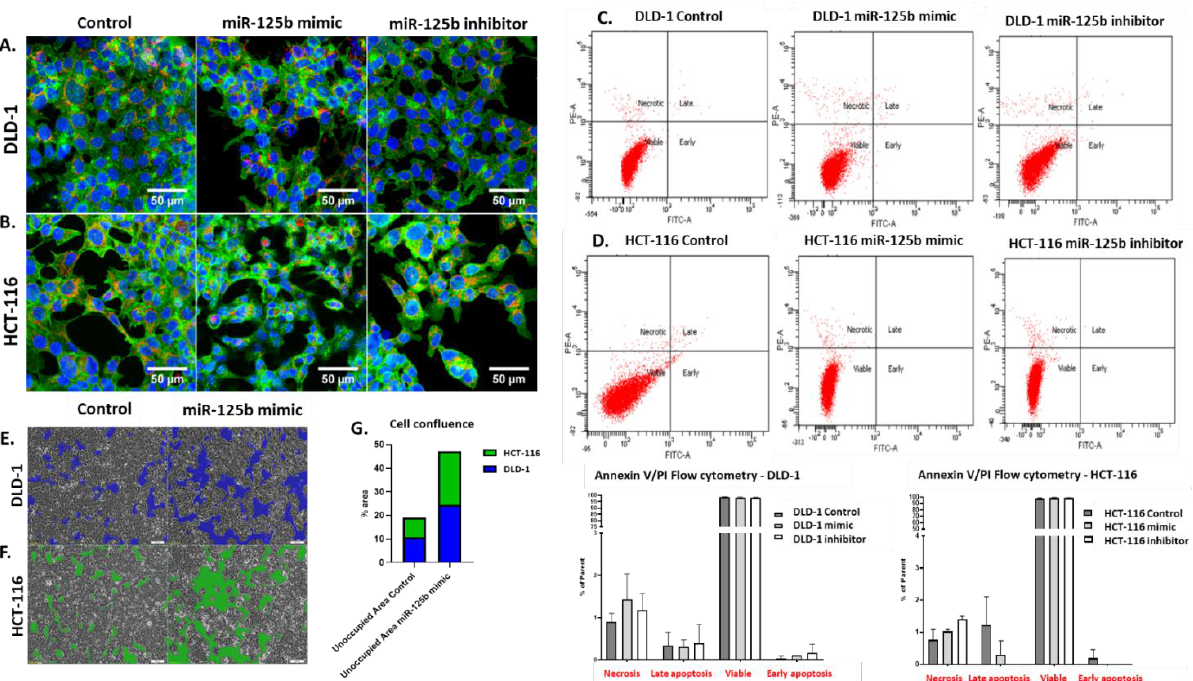
Figure 3. miR-125b modulation effects on cell viability. ( A , B ) Fluorescence staining of ( A ) DLD-1 and ( B ) HCT-116 marked for nucleus (blue), mitochondria (red) and cytoskeleton (green) used for detection via confocal microscopy of morphological changes upon miR-125b treatment with mimic sequences (100nM) and inhibitor sequences (100 nM) compared to control. The original picture contrast and luminosity were increased by 20%. ( C , D ) Flow cytometry analysis for detection of early and late apoptotic events, as well as necrosis for ( C ) DLD-1 and ( D ) HCT-116 treated with miR-125b mimic (100 nM) or inhibitor (100 nM) compared to control. Experiments were performed in biological triplicates for each cell line and each treatment scheme (data presented as mean ± S.D.; all the compared groups had a non-significant p value: p > 0.05, independent t -test compared to HCT-116 control). ( E , F ) Images of ( E ) DLD-1 and ( F ) HCT-116 cell confluence at 48 h after miR-125b mimic transfection (100 nM) and ( G ) analysis of occupied area. The pictures were taken with an inverse optical microscope at 4× magnification and processed with Image J software.